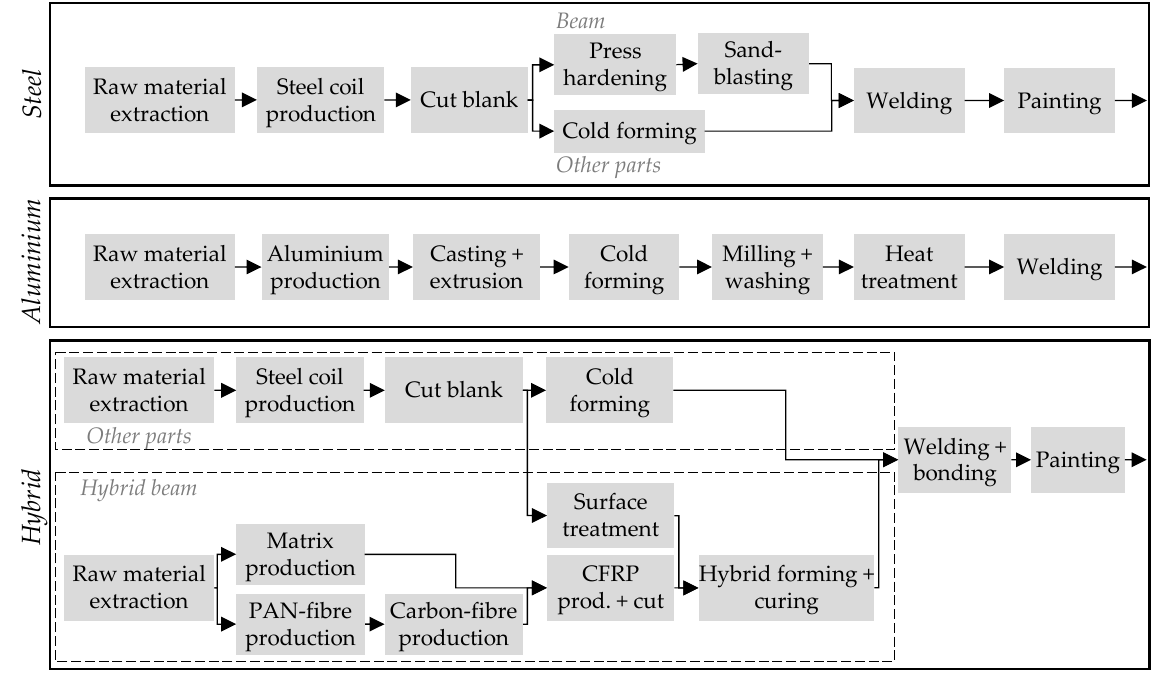
Figure 3. Manufacturing routes of the three CMS design alternatives.